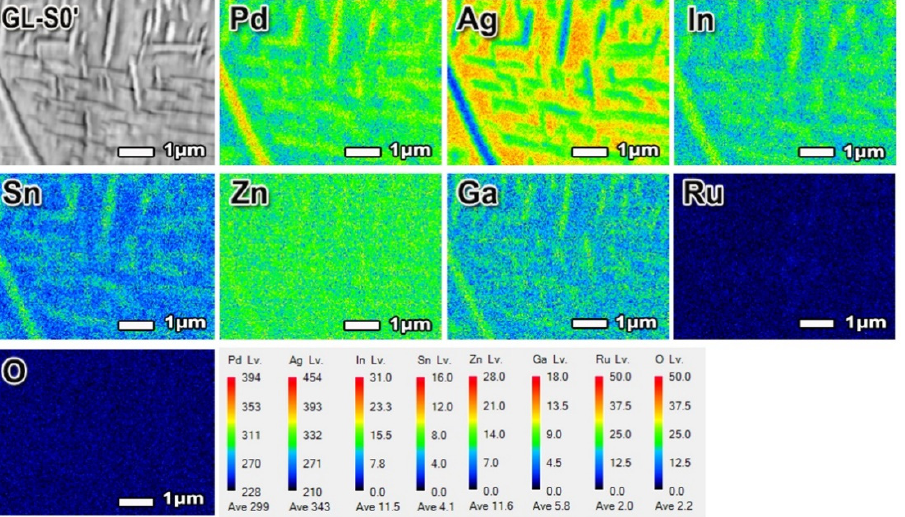
Figure 8. FE-EPMA mapping of GL-S0 ′ (20,000×).